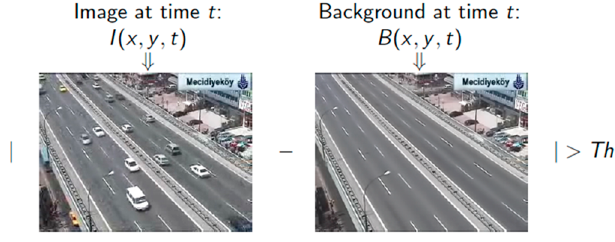
Figure 1. Basic approach of background subtraction method.